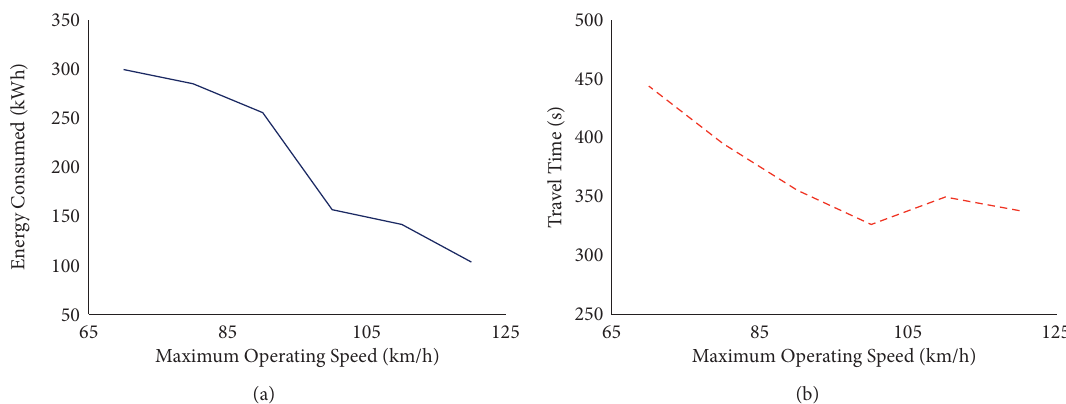
Figure 5: Consumed energy and travel time vs. maximum operating speed. (a) Energy vs. maximum speed. (b) Travel time vs. maximum speed.